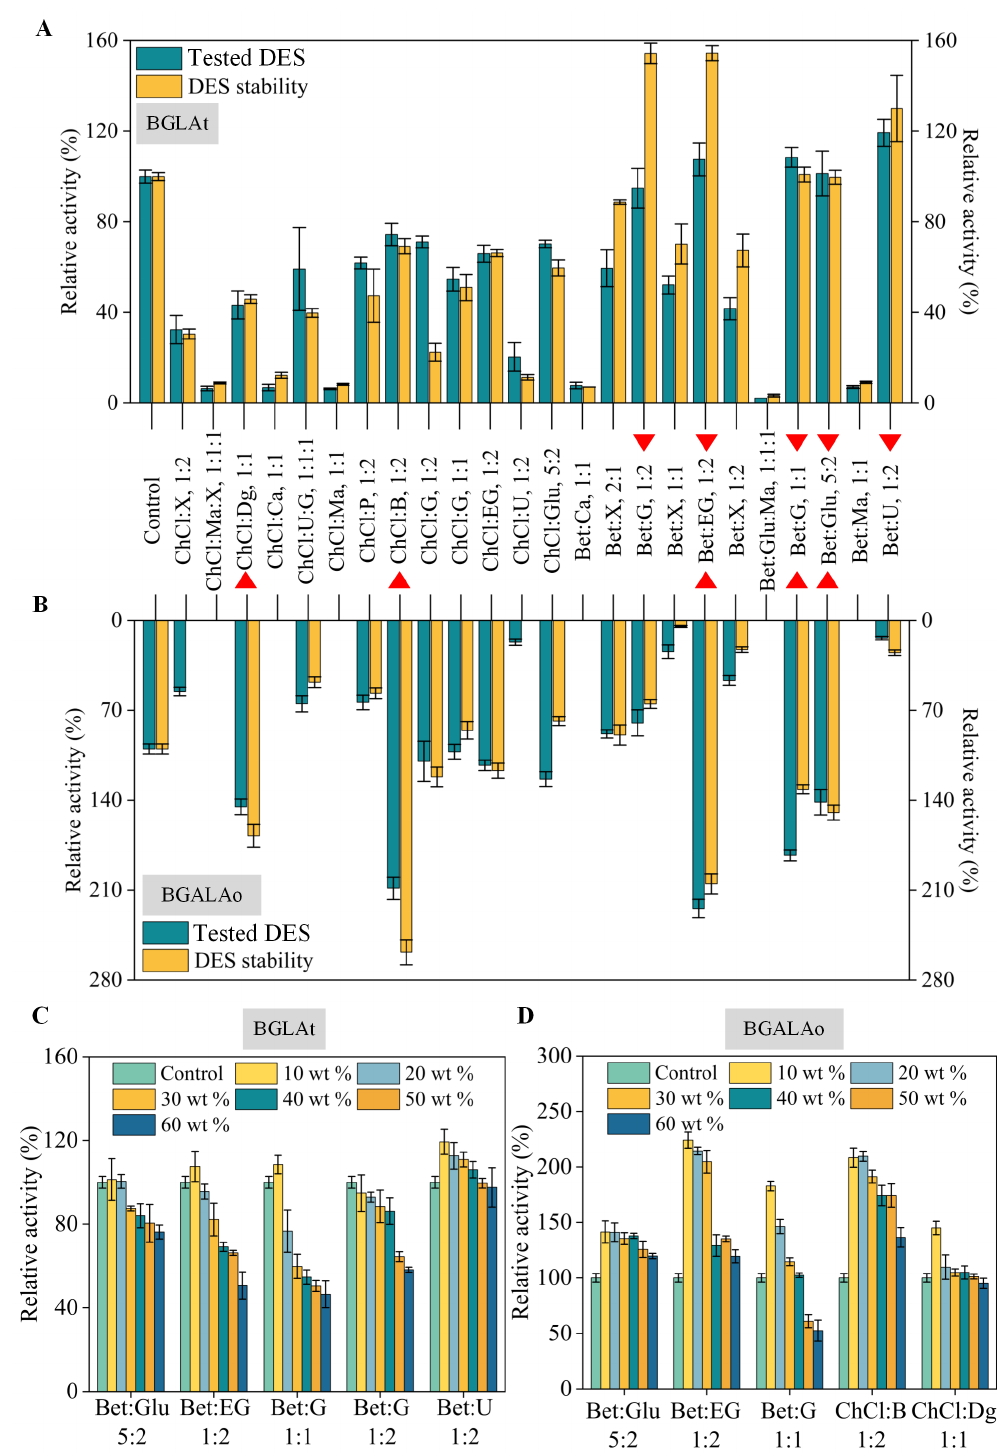
Figure 1. Effects of types and concentrations of DES on the activity and stability of combinatorial enzymes (BGLAt and BGALAo). ( A ) Study of BGLAt optimal DES (50 ◦ C) and DES stability (50 ◦ C, 1 h). ( B ) Study of BGALAo optimal DES (50 ◦ C) and DES stability (50 ◦ C, 1 h). The reaction medium is 10 wt % DES-buffer (citric acid buffer (20 mM, pH 6.0) contains 10 wt % of DES (Bet: EG, 1:2)) ( A , B ). ( C ) Effects of concentrations (10, 20, 30, 40, 50, and 60 wt %) of DES on the activity of BGLAt (50 ◦ C). ( D ) Effects of concentrations (10, 20, 30, 40, 50, and 60 wt %) of DES on the activity of BGALAo (50 ◦ C). The activity without DES, used as the control, was defined as 100% ( A – D ). Error bars represent the corresponding standard deviation of three independent experiments ( n =